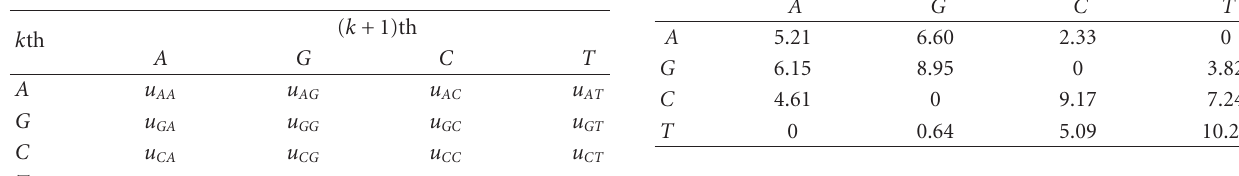
Table 7: Controls corresponding to transfer between bases within one step. The leftmost column denotes the state k th step, and the upmost row denotes the ( k + 1)th state.